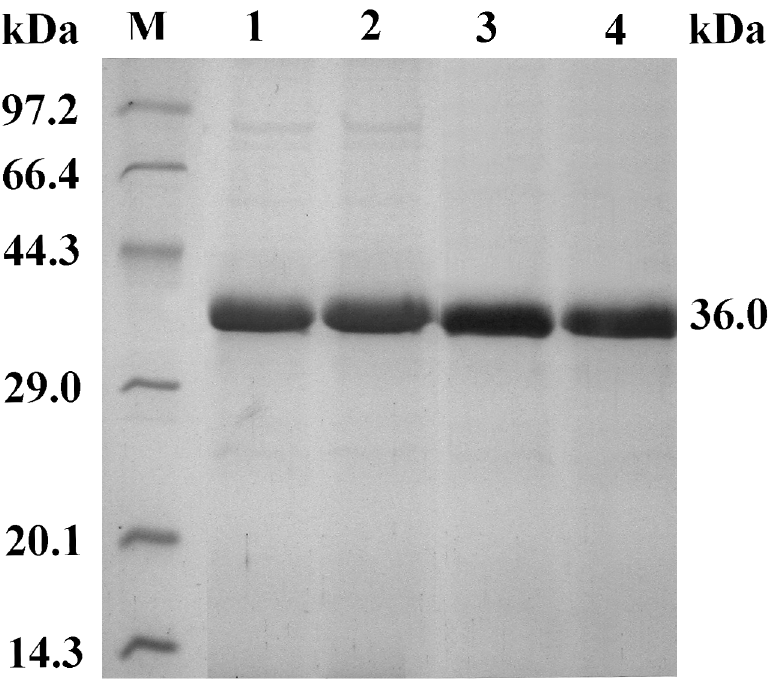
Fig 4. SDS-PAGE analysis of the re-AuFaeA and re-AuFaeA A126C-N152C . Lane M, standard protein marker; lane 1 and 2, the cultured supernatants of re-AuFaeA and re-AuFaeA A126C-N152C ; lane 3 and 4, the purified re-AuFaeA and re-AuFaeA A126C-N152C with same molecular weights of 36.0